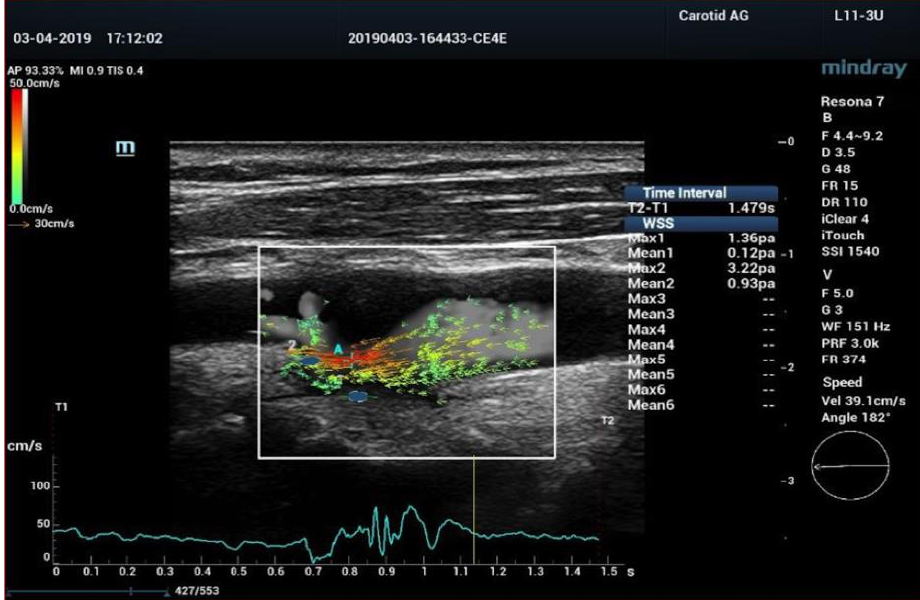
Figure 6. V-flow imaging shows the turbulence and direction of flow with entity estimation of plaque stenosis.